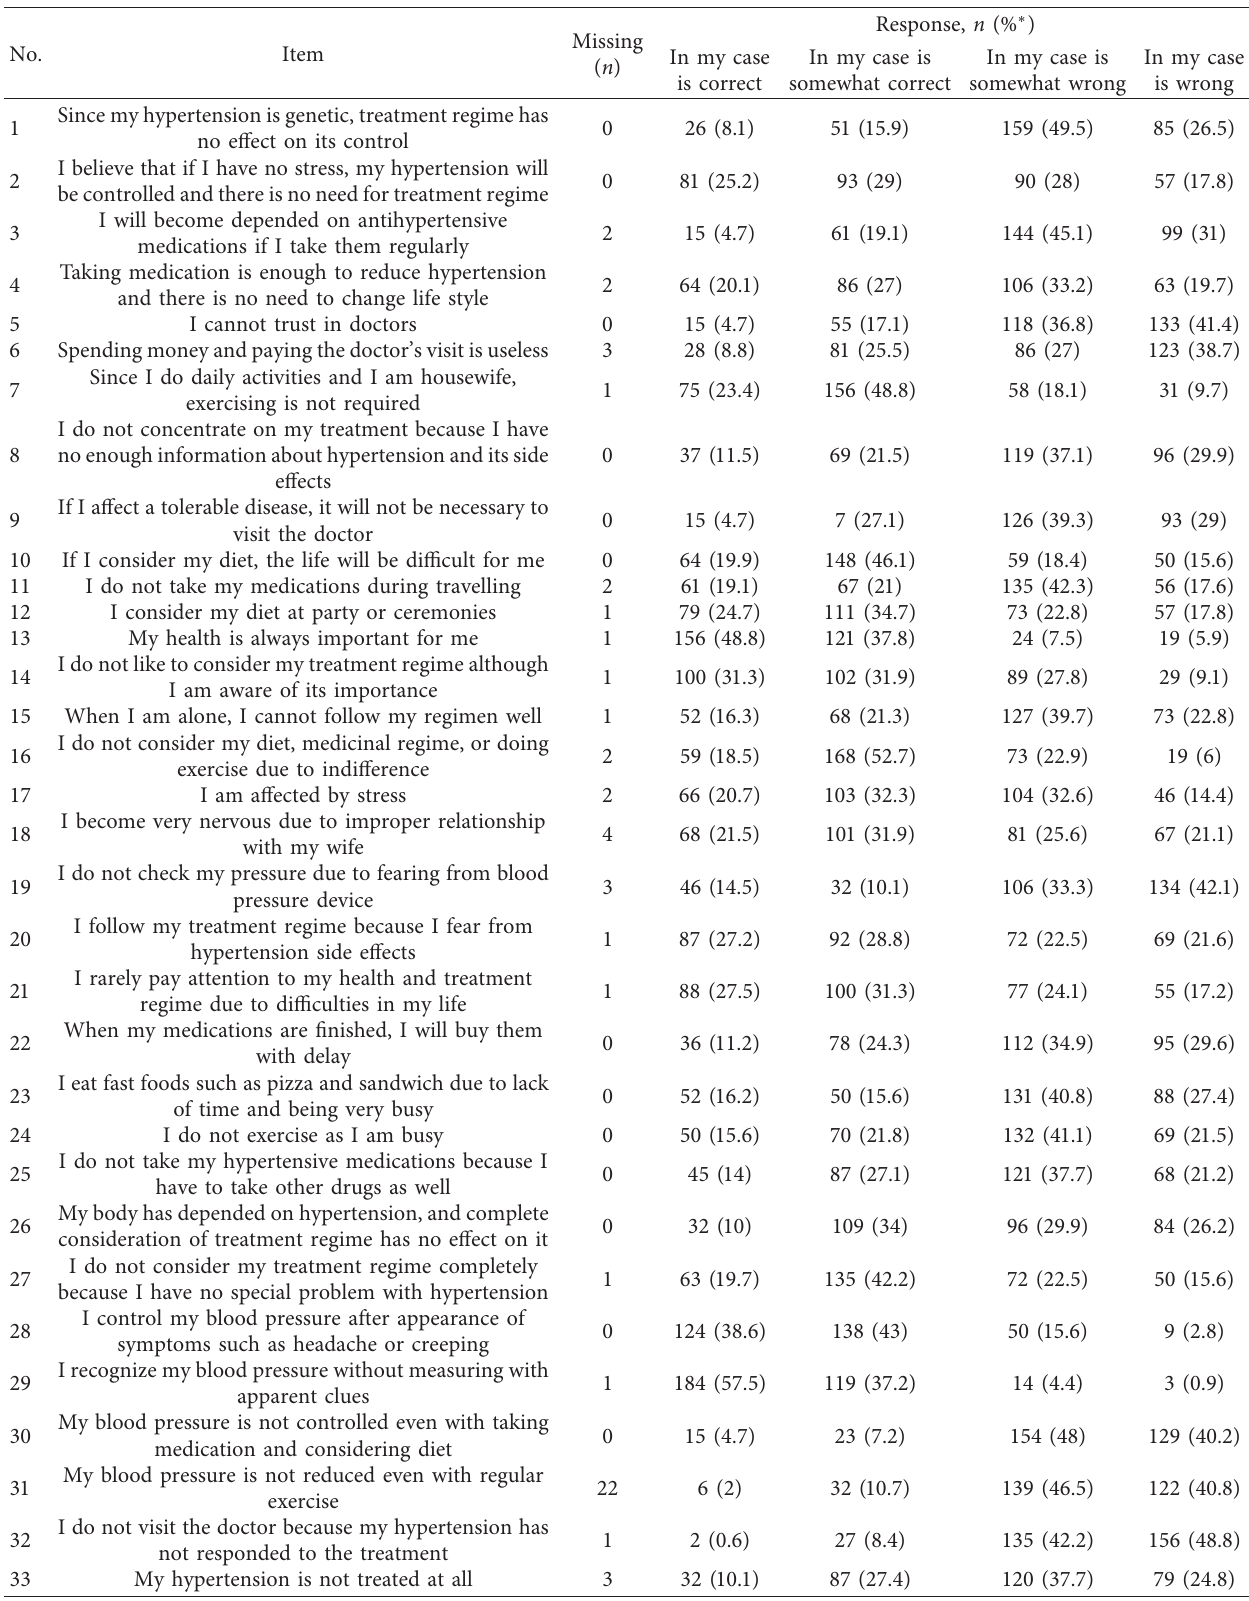
Table 4: Distribution of the responses to the factors affecting hypertensive treatment adherence scale ( n � 321). No. Item